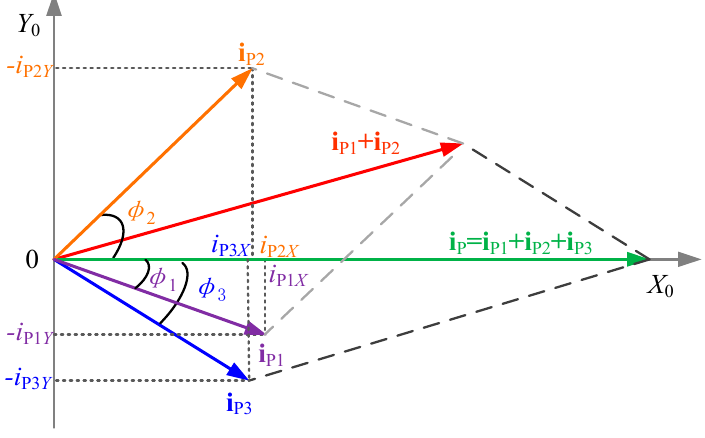
Figure 7. The decomposition of branch currents when n = 3.